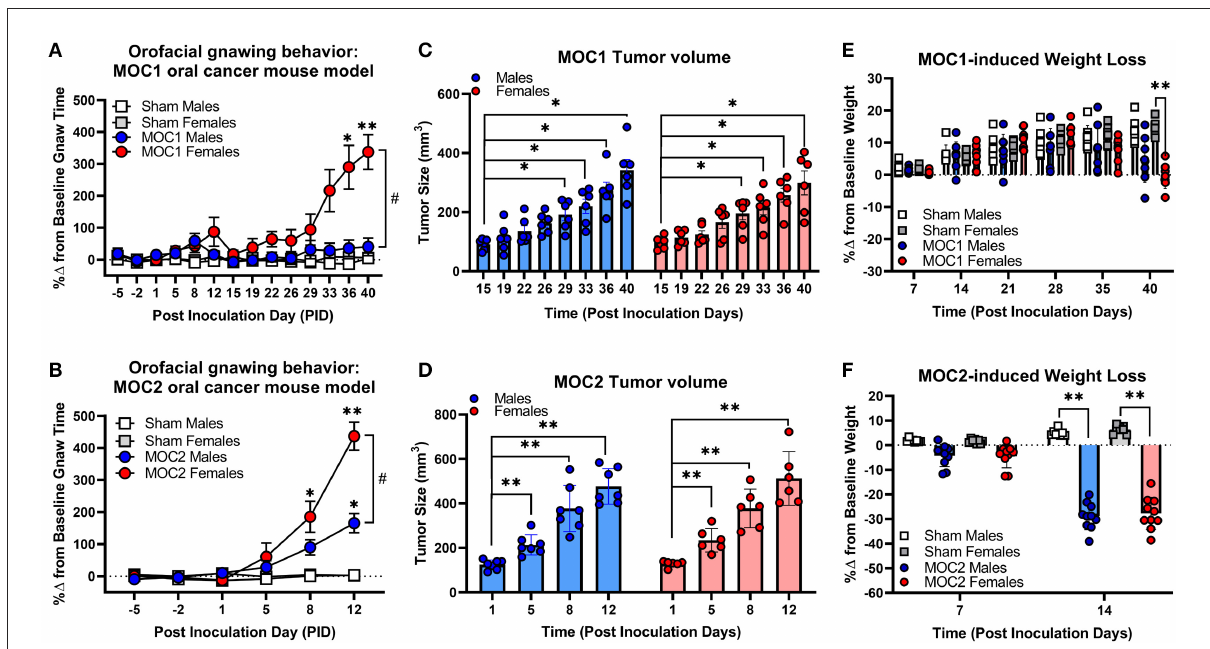
FIGURE2 Sex-specific oral cancer-induced nociceptive behavior and weight loss during tumorigenesis. Orofacial nociceptive behavior was measured in male and female sham and MOC1 and MOC2 tumor-bearing mice during tumorigenesis. Two weeks of baseline orofacial nociceptive behavior was acquired prior to inoculation. Mice were inoculated at PID0. Quantitative analysis of the percent change in baseline gnaw-time in sham mice (1:1 matrigel and cell culture media, n = 8/sex, squares), or MOC1 (A) or MOC2 (B) tumor-bearing mice ( n = 10/sex, circles). Three-Way ANOVA Repeated Measures, time by treatment * p < 0.05, ** p < 0.01; sex by time # p < 0.05. Orthotopic allograft tumor size was measured for MOC1 (C) starting at post-inoculation day (PID) 15 ( n = 6/sex) and MOC2 (D) starting at PID1 ( n = 6 female, 7 males). Tumor area was measured by caliper and volume calculated as an ellipsoid (V = 4/3 π × L × W × H). Two-way ANOVA Repeated Measures, time effect * p < 0.05, ** p < 0.01. Allograft-induced weight loss was measured weekly in MOC1 ( n = 8/sex) (E) and MOC2 (F) tumor-bearing mice ( n = 10/sex) and compared to sham-treated mice ( n = 8/sex). Three-Way ANOVA Repeated Measures, time by treatment * p < 0.05, ** p <